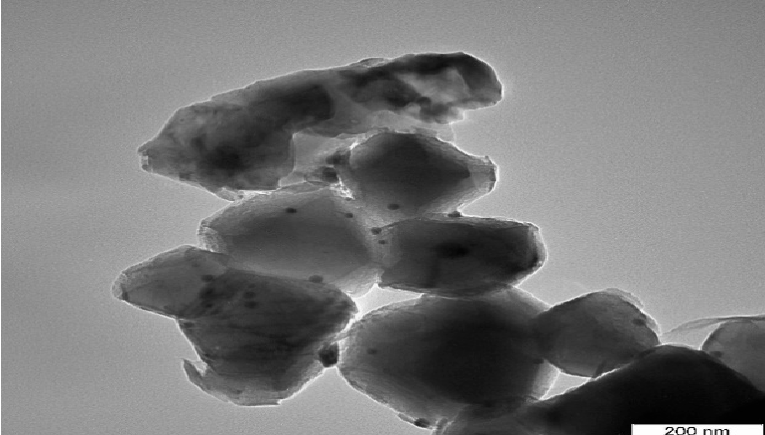
Figure 12. TEM analysis of the spent Pt,Pd,Ni/Mg 0.85 La 3+0.15 O catalyst after reaction: at 900 °C, and CH 4 :CO 2 ratio 1:1.